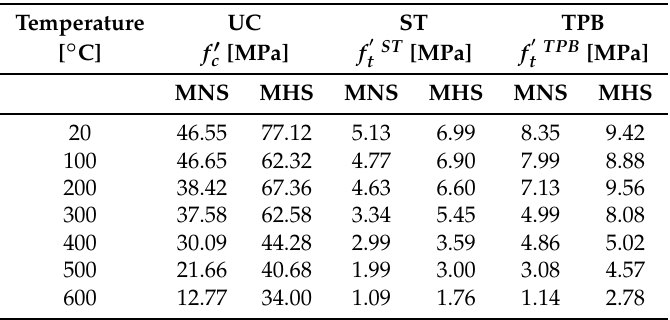
Table 5. Mean peak stresses in UC, ST and TPB